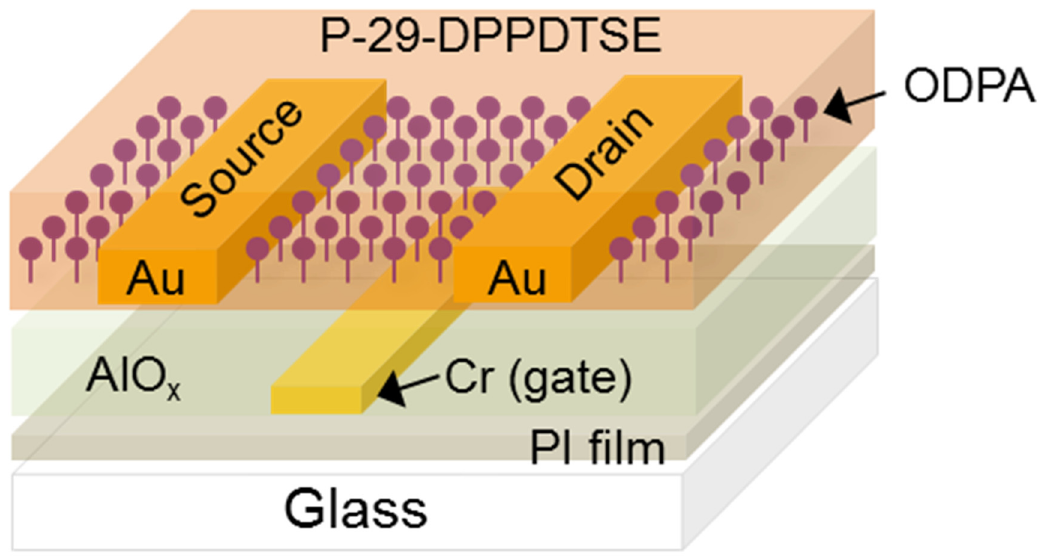
Figure 4. Schematic diagram of high-performance P-29-DPPDTSE polymer semiconductor device on a flexible PI film/glass substrate with DUV-annealed AlO x gate dielectric layers (not to scale).